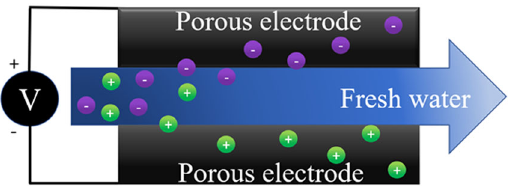
Fig. 1 A schematic illustration of the working of a typical CDI device. In a CDI device, water fl ows through a cell with two porous electrodes. A voltage applied to these electrodes induces an electric fi eld removing ions from the solution by electrosorption on the electrodes.